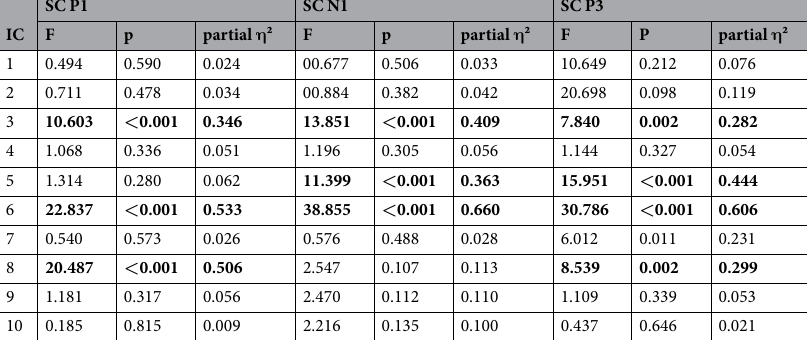
Table 1. Overview of independent component analyses. In this table, we summarized the results of the repeated-measures ANOVAs for all ten ICs. Significant differences are marked with bold font. Please note that due to Bonferroni-correction, the significance threshold was lowered to p ≤